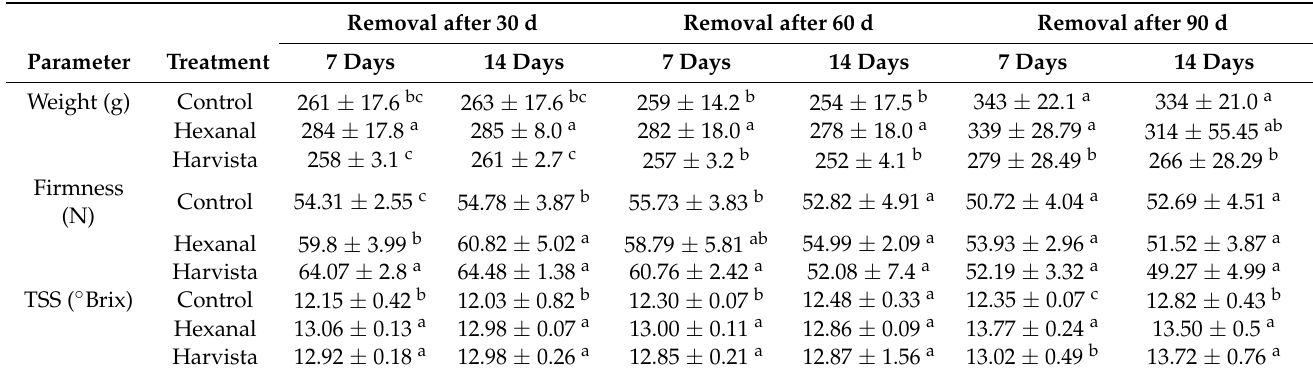
Table 3. Effects of preharvest sprays on fruit quality traits fresh weight, firmness and TSS in ‘Honeycrisp’ apples after removal from cold storage (2.5 ◦ C) to room temperature storage (~20 ◦